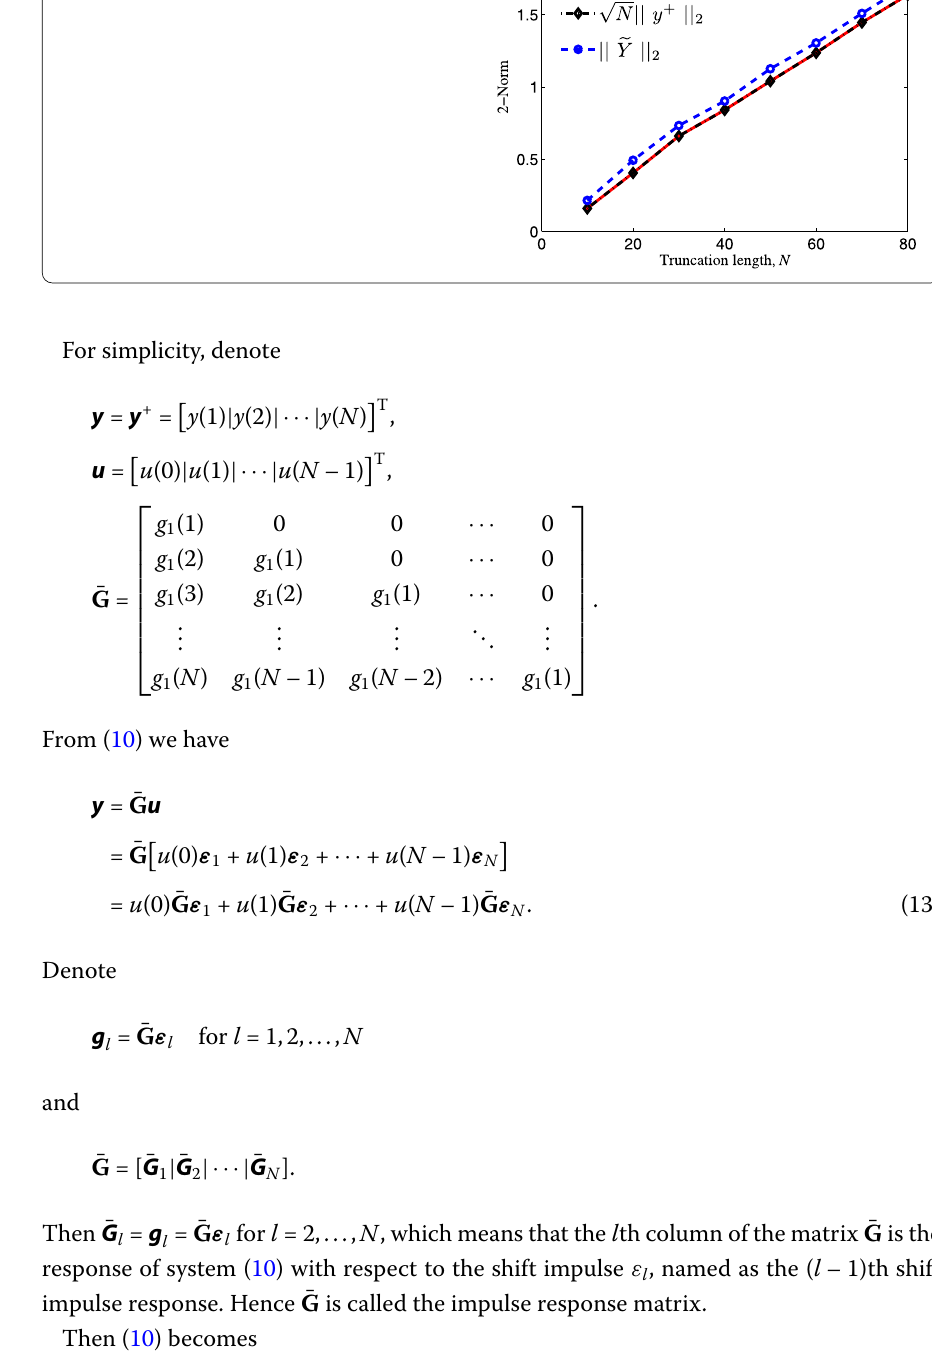
Figure 4 Energy tendency of output and its